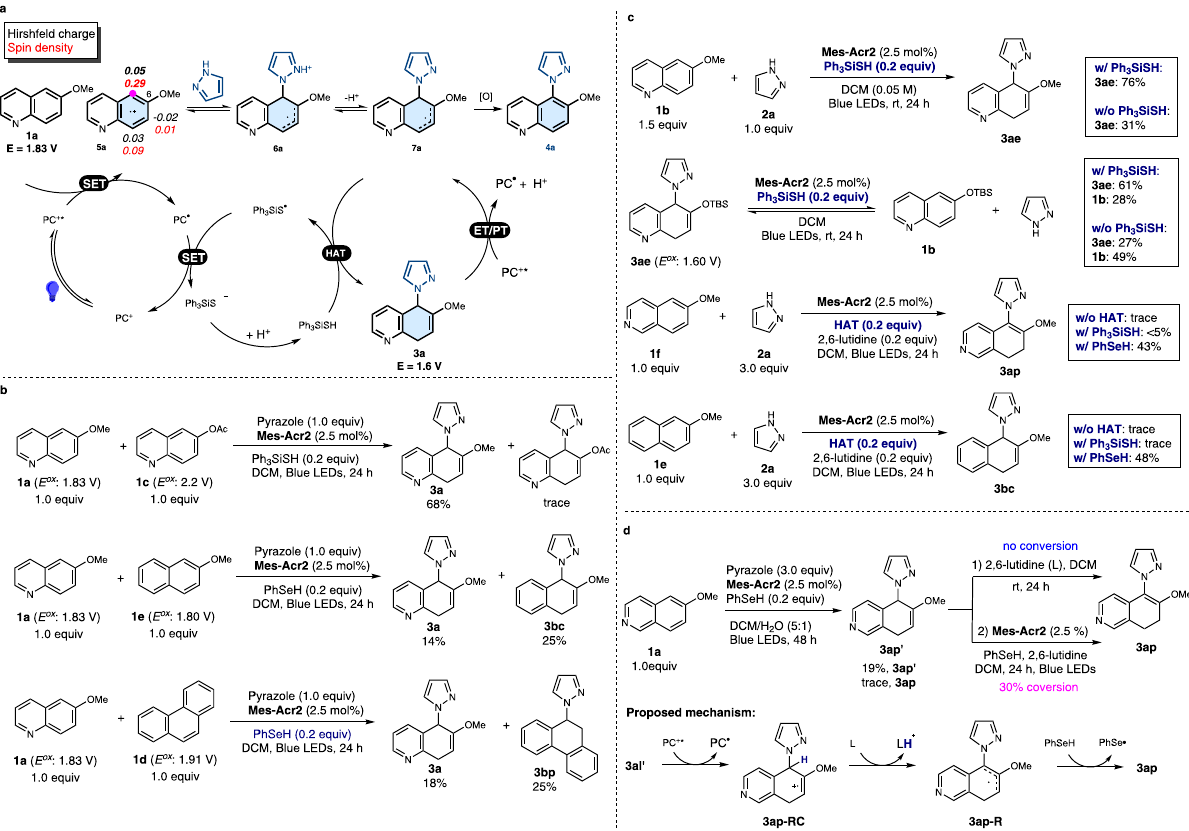
Fig. 4 | Mechanistic studies. a Proposed catalytic cycle. b Chemoselectivity studies. c Study of roles of HAT reagent. d Study of regioselectivity of isoquinoline engaged